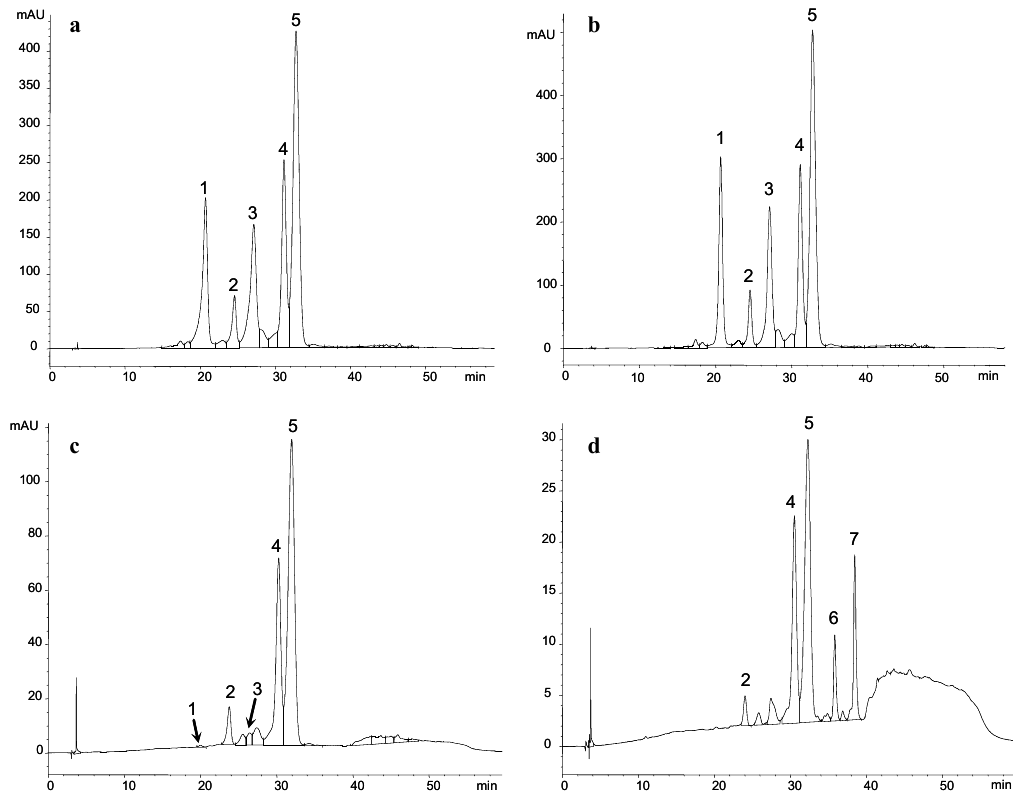
Figure 1. Chromatographic profile of model systems A ( a , c ) and AF ( b , d ) at day 0 ( a , b ) and at day 98 ( c , d ) recorded at 520 nm (each shown in full scale). Peaks 1 to 5: 3- O -glucosides of delphinidin, cyanidin, petunidin, peonidin, and malvidin, respectively. Peak 6, A and B-type vitisins of peonidin 3- O -glucoside. Peak 7, A and B-type vitisins of malvidin 3- O -glucoside.